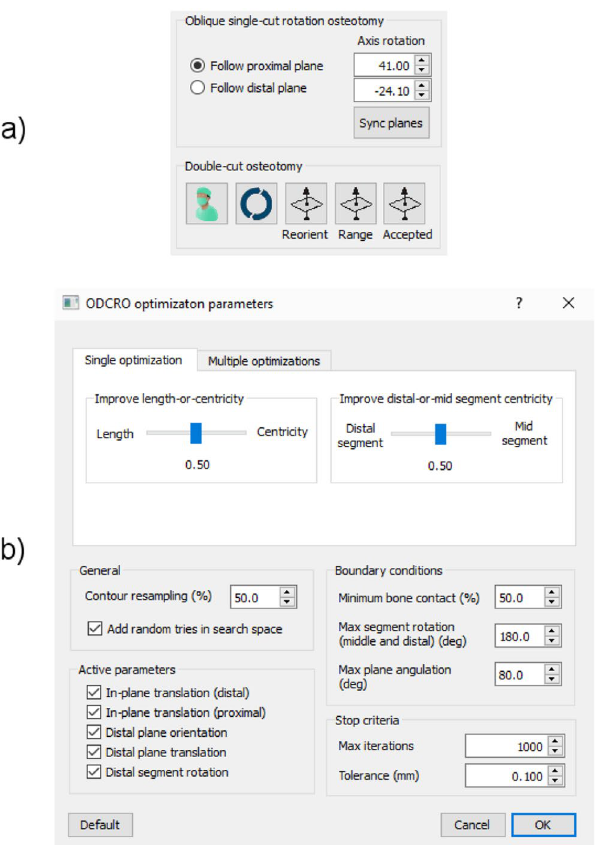
Figure 6. ( a ) User interface to control performing an oblique double-cut rotation osteotomy manually, or, ( b ) to set the optimization parameters for the automatic